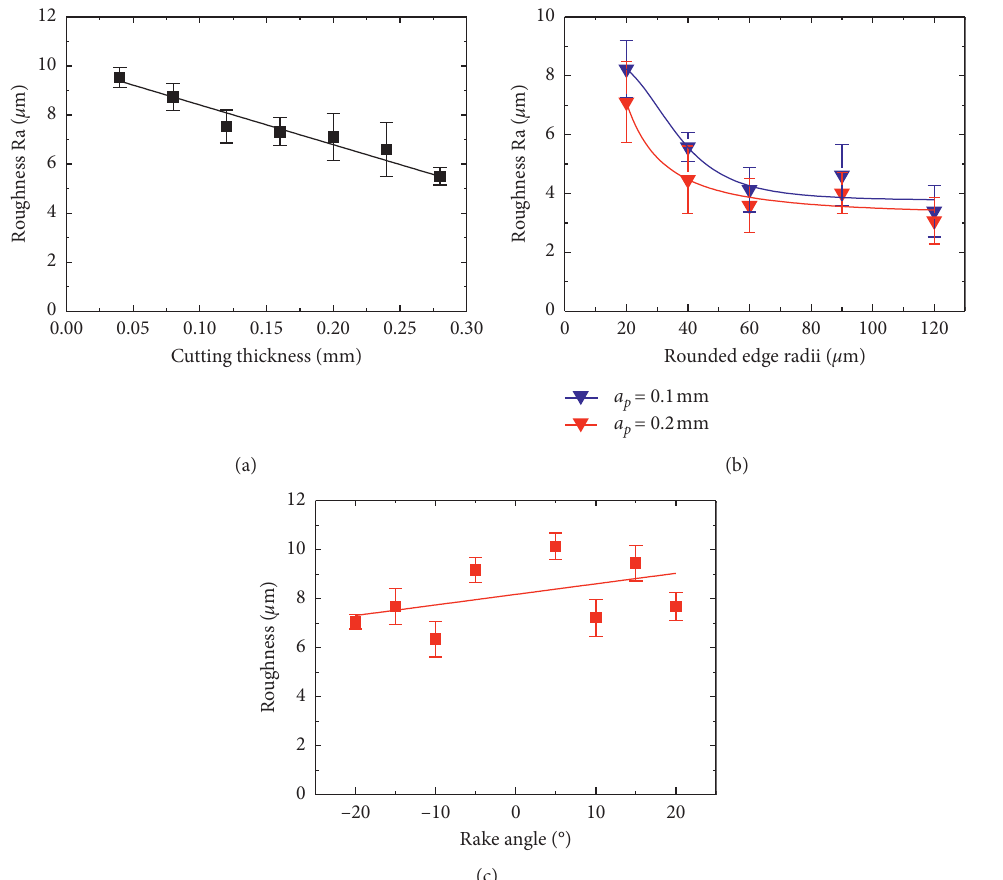
Figure 3: Influence of (a) cutting thickness, (b) rounded edge radius, and (c) rake angle on machined surface roughness.